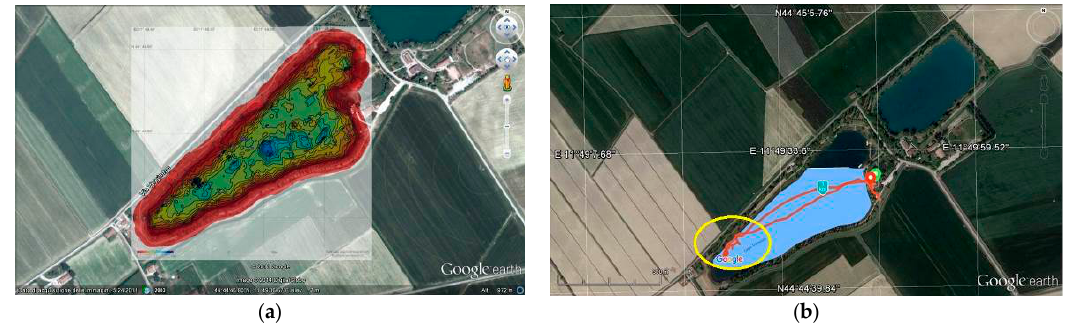
Figure 5. Lago Tramonto in Gambulaga, Portomaggiore (FE, Italy): ( a ) A view of the georeferenced bathymetrical plan, with an indication of the underwater site; ( b ) Positioning of the main ancient anomalies (yellow oval).